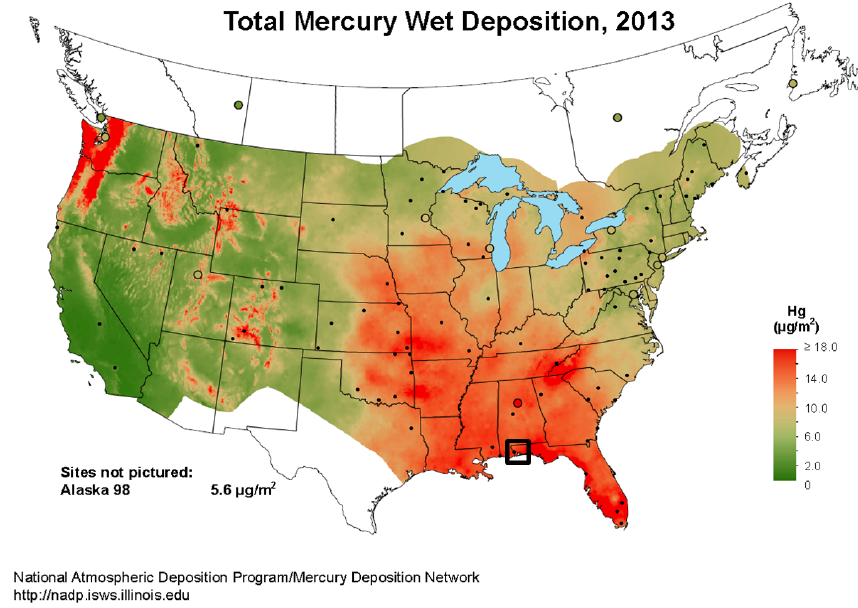
Figure 1. Total mercury wet deposition in the US for 2013. The highest levels of Hg deposition are observed in the southeastern US, where no local and regional sources are located immediately upwind. The black square indicates the measurement